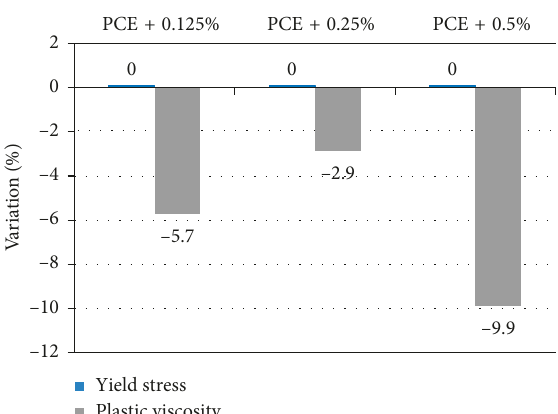
Figure 11: Variation of yield stress and plastic viscosity of nanomodified cement pastes with PCE.